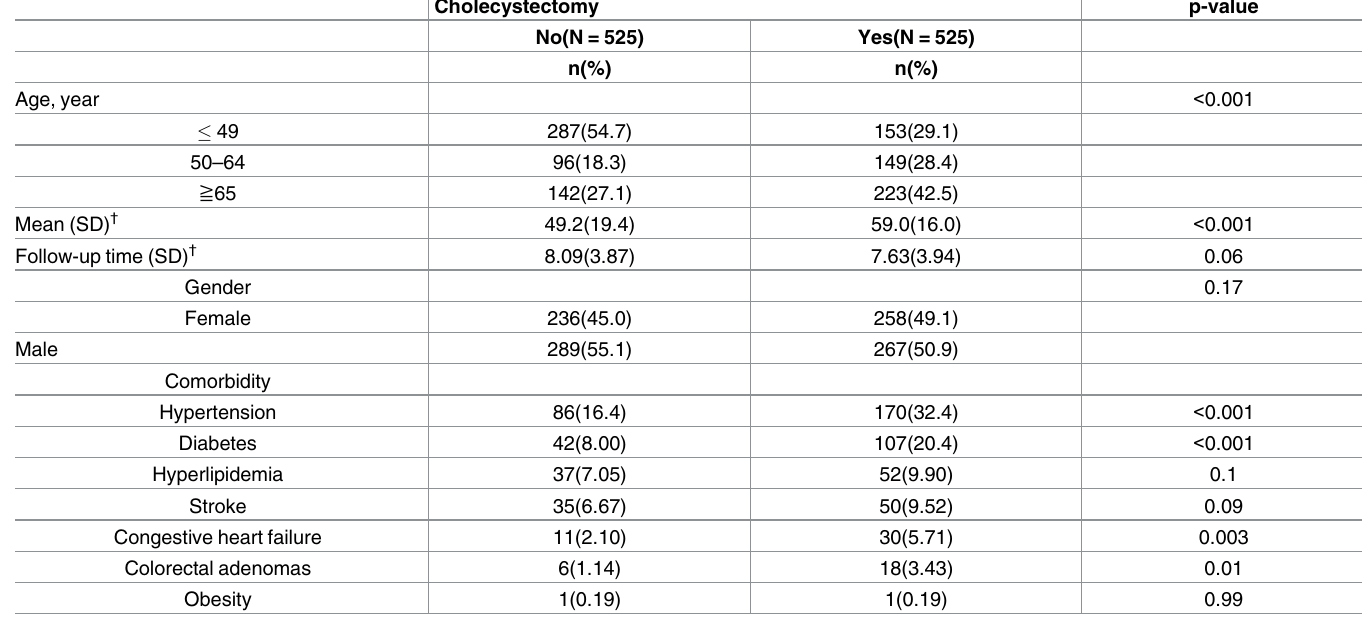
Table 1. Comparison of demographics and comorbidity among inflammatory bowel disease patients with cholecystectomyand without cholecystectomy.